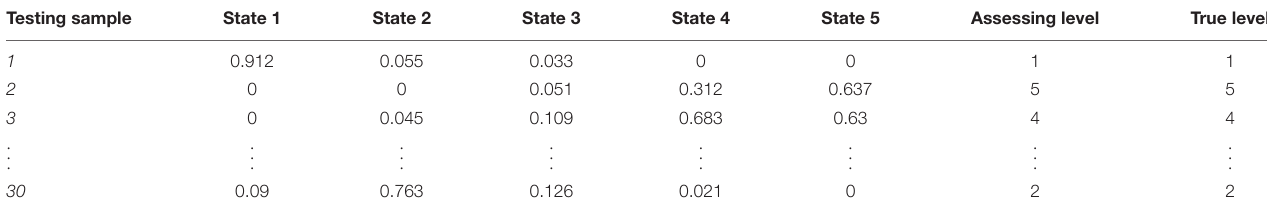
TABLE 7 | Posterior probability distribution and risk level of marine disaster. Testing